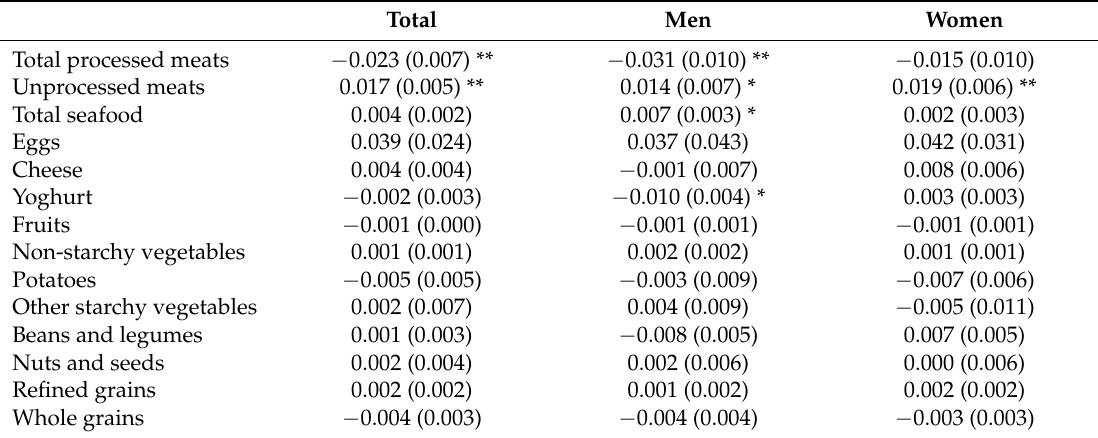
Table 7. Linear association between major food group intake and BMI levels in the study